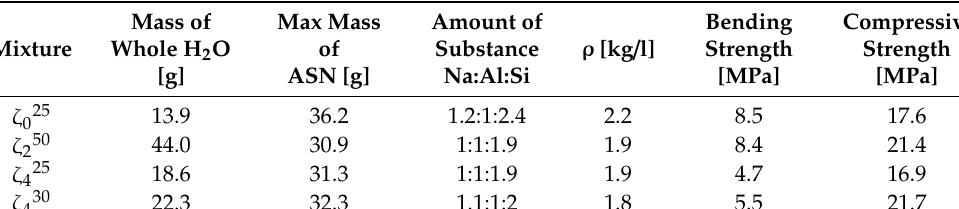
Table 13. Density, bending, and compressive strength of AAM prepared with close to literature’s favourable amounts of substance ratios for the first group, Al and Si [34], cured on 70 ◦ C for one day, measured one week after molding.